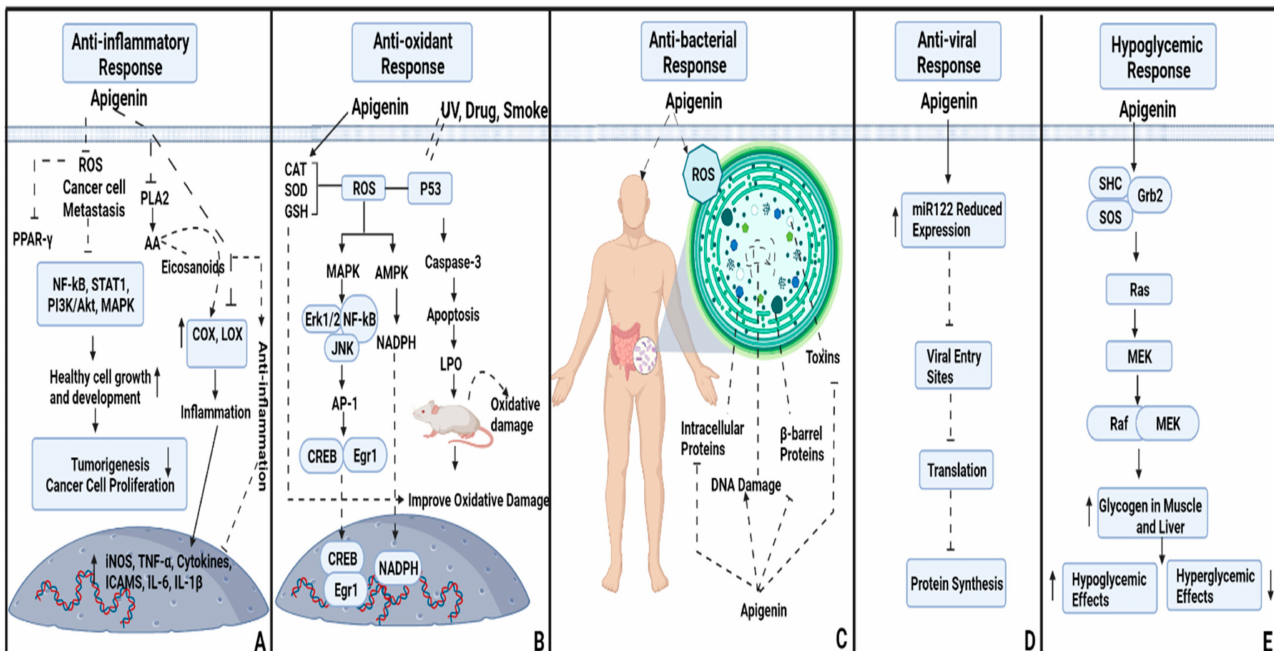
Figure 1. Detailed mechanism of the pharmacological properties of apigenin. ( A ) Anti-inflammatory response; apigenin inhibits the activity of reactive oxygen species and cancer cell metastasis which further inhibits several cell signaling pathways. It promotes the growth and development of healthy cells and downregulates the expression of cancer cell metastasis. Moreover, it blocks the activity of the phospholipase A2 (PLA2) enzyme which releases from the plasma membrane. Generally, PLA2 induces arachidonic acid (AA), which is a precursor of eicosanoid. Apigenin inhibits the